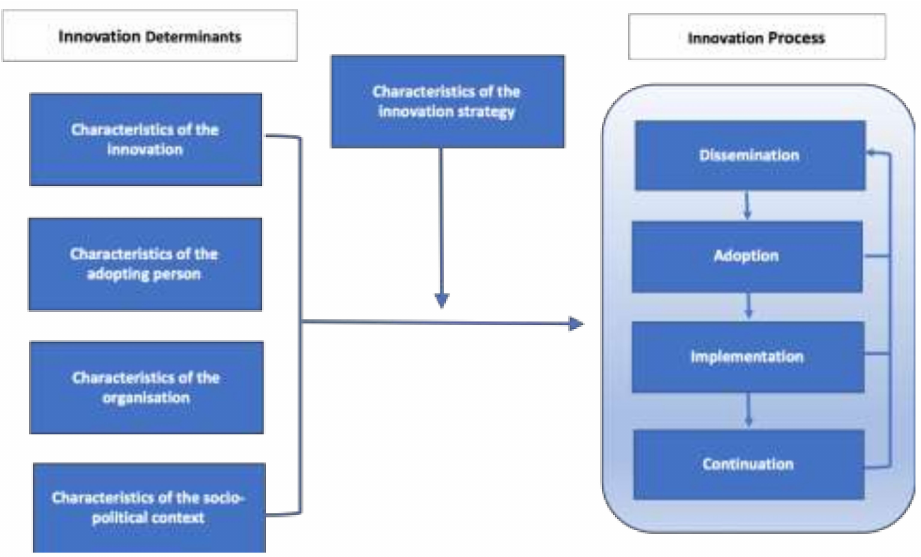
Figure 2. Framework representing the stages in innovation process and the determinants that influence the process. Derived from Fleuren et al.